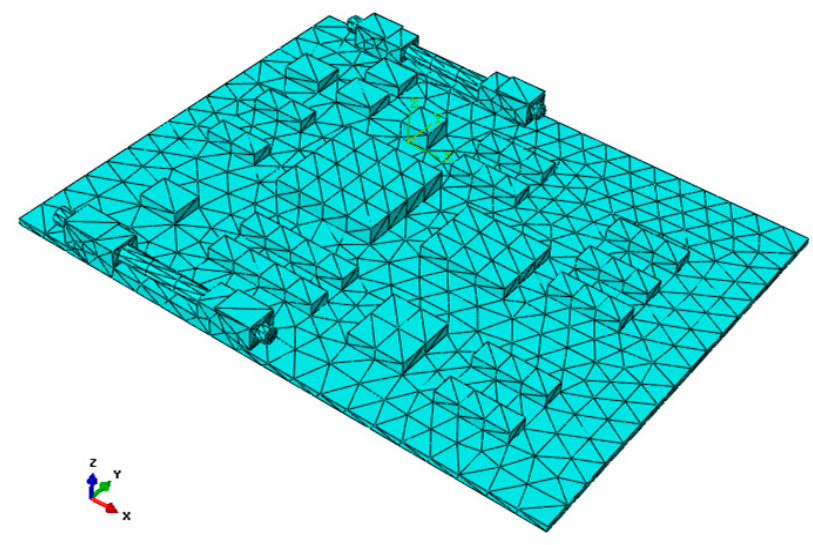
Figure 1. Finite element model of the CPU board. Table 1. Material parameters of the CPU board model.